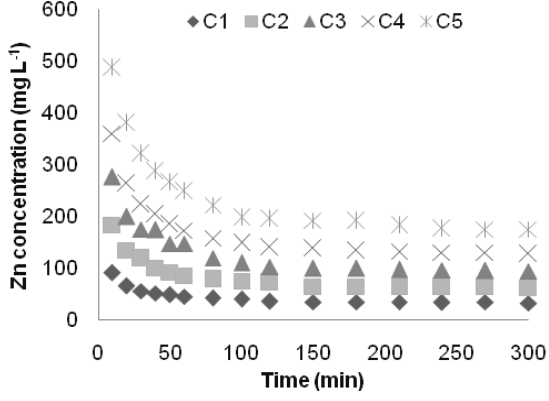
Figure 4. Effect of initial concentration on zinc sorption by Amberlite IRA410; C1 = 300 mg L -1 , C2 = 500 mg L -1